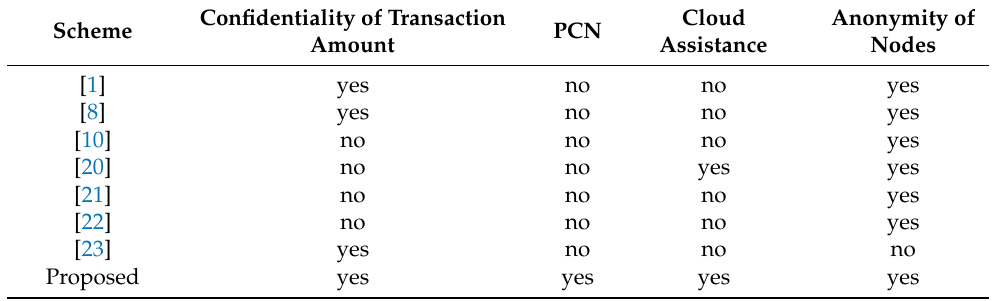
Table 1. Scheme comparison.